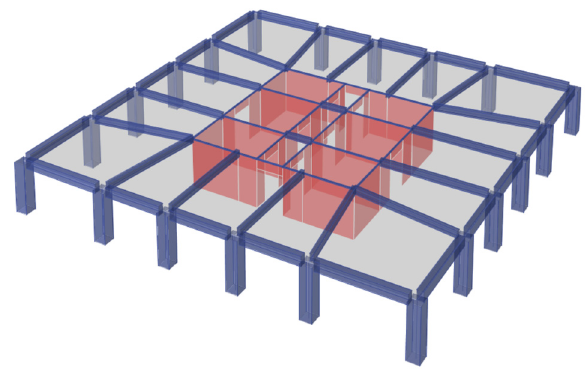
Figure 12. Three ‐ dimensional view of one typical floor.